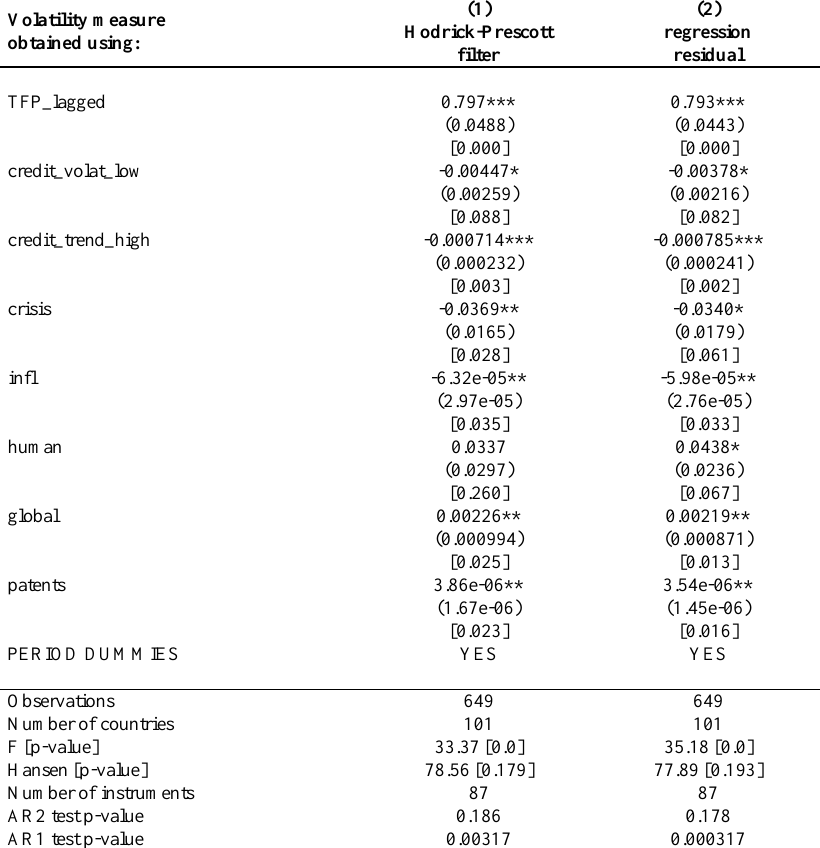
Table 2. Determinants of (the log of) TFP: credit volatility in less technologically advanced